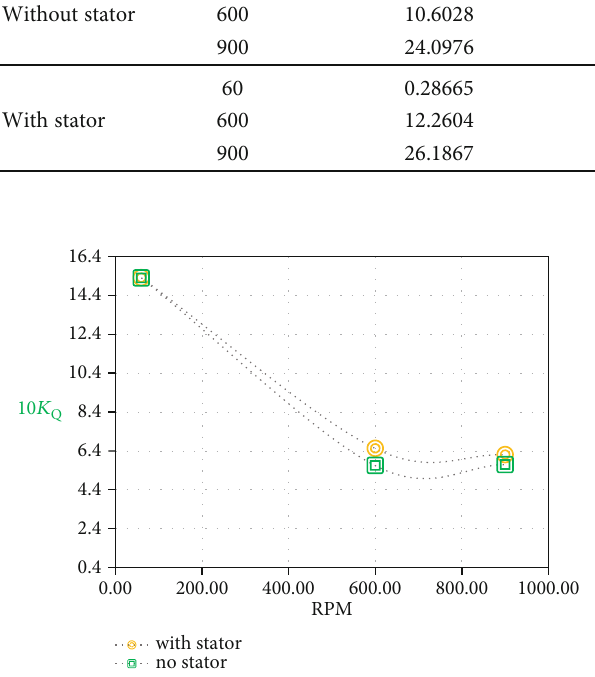
Figure 16: Comparison of torque coe ffi cient in bollard pull mode in the presence and absence of a stator.